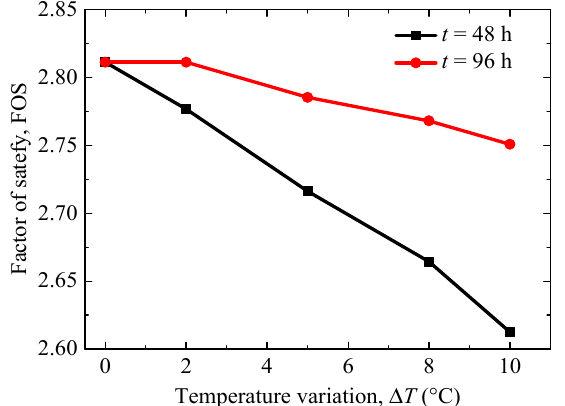
Figure 15. Factor of safety (FOS) of the cutting slope with daily temperature variation ( Δ T ).